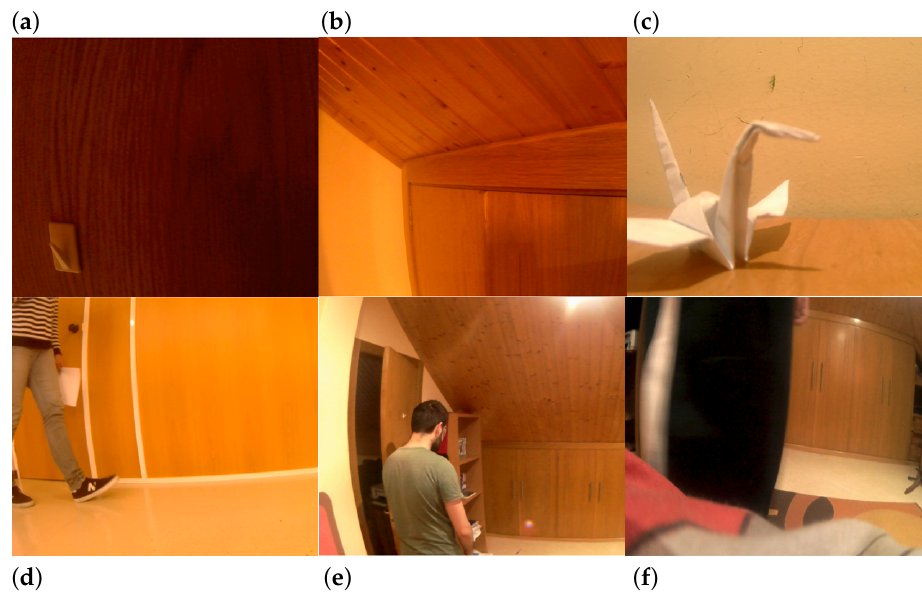
Figure 1. Sample frames of the six video recordings employed. ( a ) On the top left, there is a snapshot of a static video, recording a dark wall, while ( b ) on the top middle there is a snapshot of a static video, which captures the interior of a room. ( c ) On the top right, a table is depicted on which an object is placed. ( d ) On the bottom left, a person is constantly moving in an office. ( e ) On the bottom middle, there is a room with different textures and a person is moving covering a large part of the camera field many times. ( f ) On the bottom right, a person is moving in front of the camera lens inside a